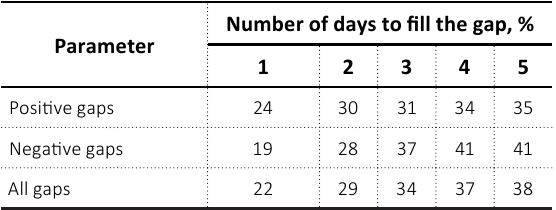
Table 3. Fill the gap effect in the Ukrainian stock